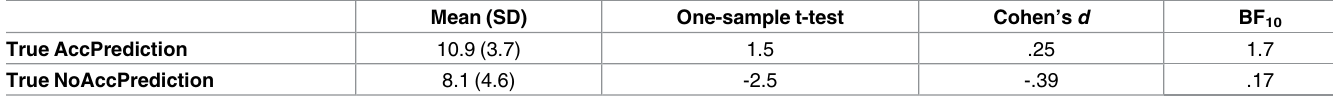
Table 1. Descriptiveand inferential statistics relative to behavioural performance in the active task.